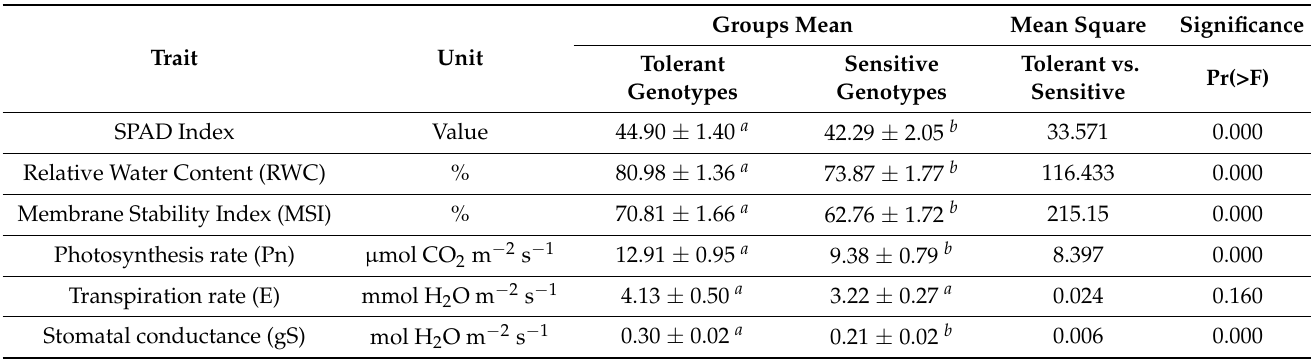
Table 6. Effects of salinity stress on tolerant and sensitive onion cultivars through group comparison